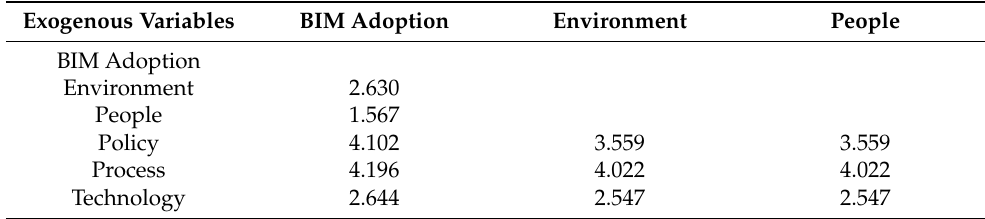
Table 10. Multicollinearity—Inner VIF